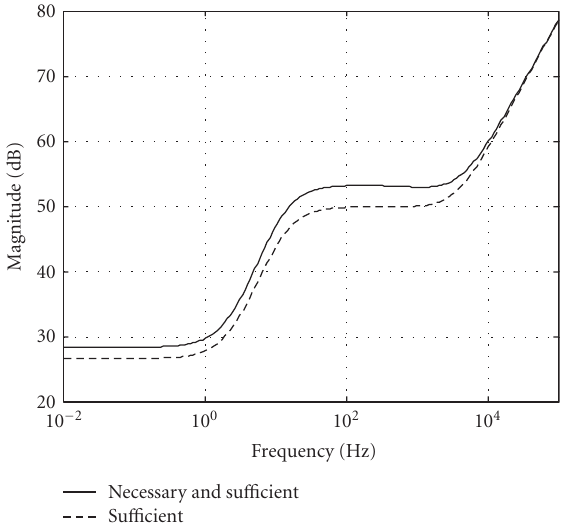
Figure 5: The robust performance bounds derived for the given system configuration.